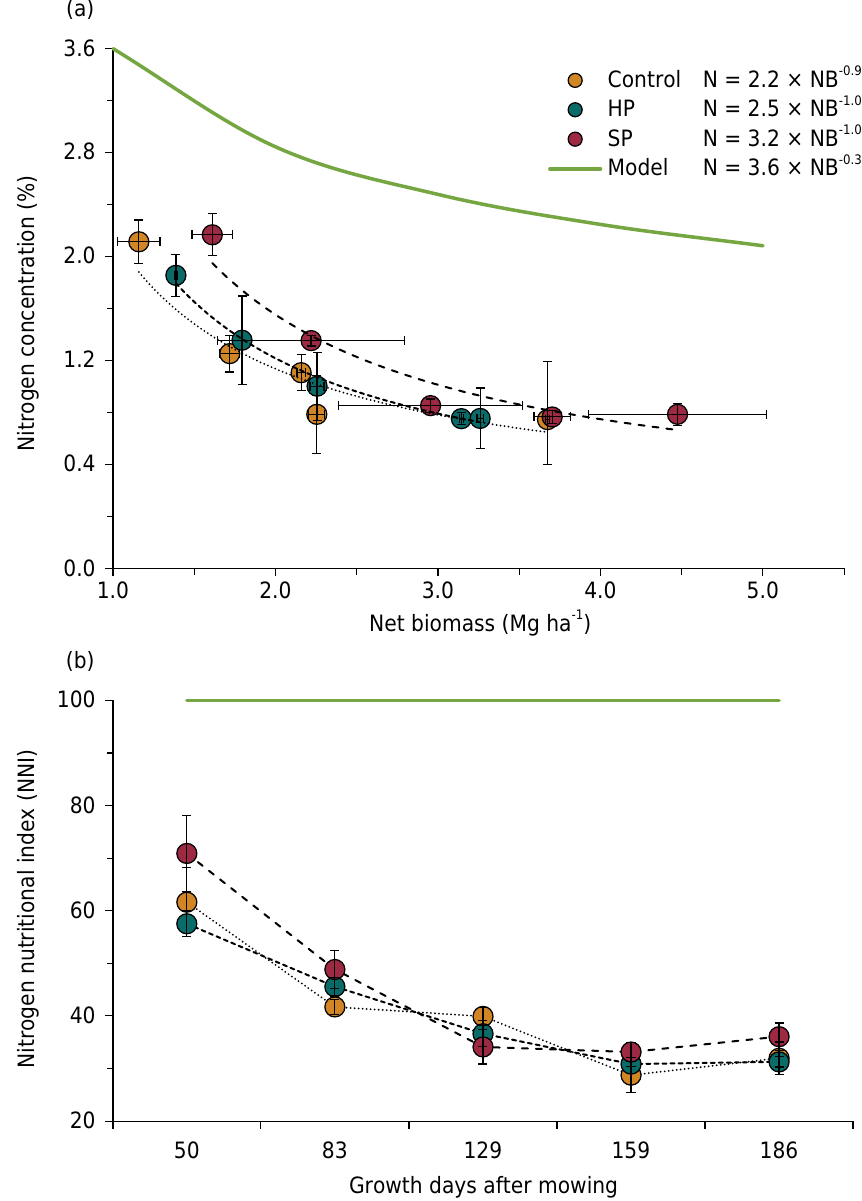
Figure 4. Nitrogen dilution curve in the aboveground biomass net accumulated (a); nitrogen nutrition index (NNI) over time (b) in a natural grassland from Southern Brazil with the application of different P sources. Control: without P addition; HP: hyperphosphate; SP: superphosphate; Model: model suggested by Bélanger and Gastal